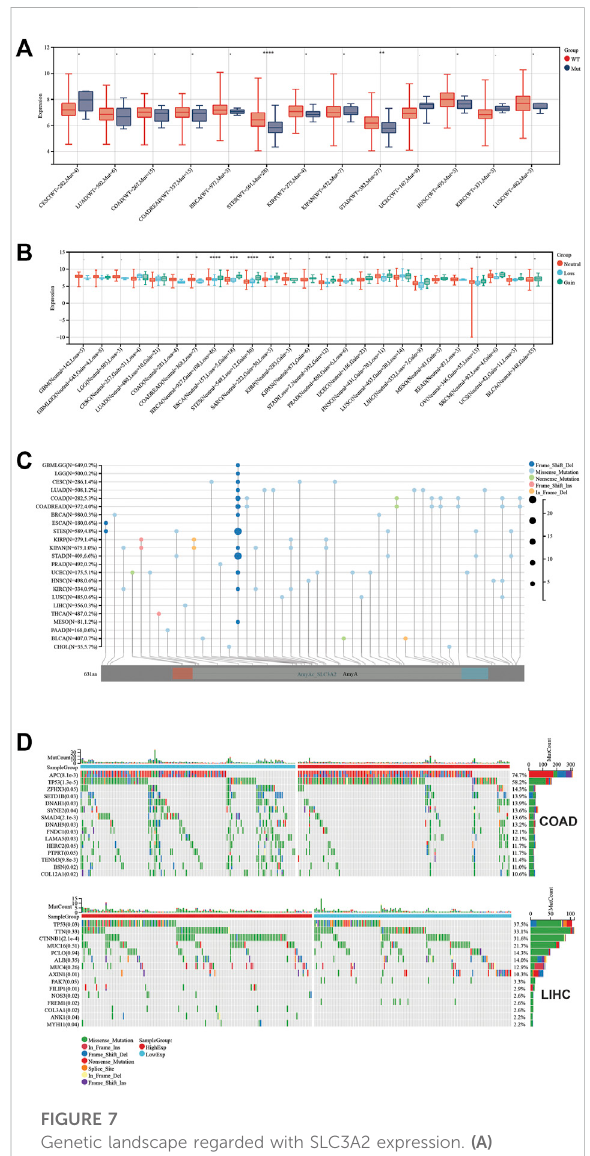
FIGURE 7 Genetic landscape regarded with SLC3A2 expression. (A) Association between SLC3A2 mutation and expression. (B) Association between SLC3A2 copy-number variation and expression. (C) Mutation pro fi le of SLC3A2 across cancers. (D) Mutation pro fi les were distinct between samples with high and low SLC3A2 in COAD and